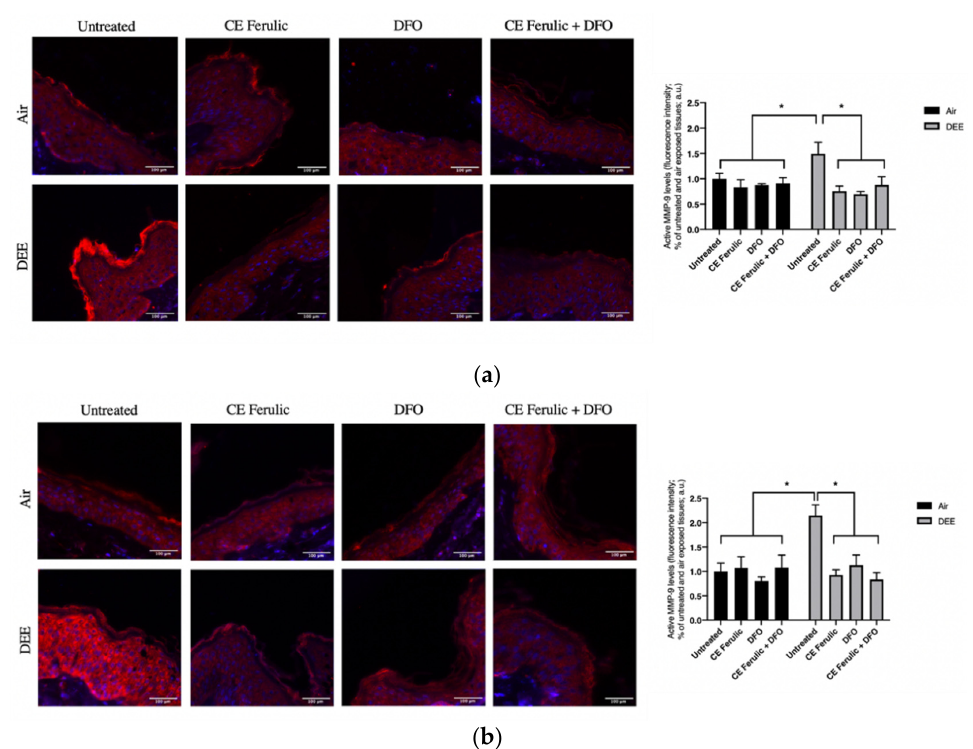
Figure 3. Skin exposure to DEE induces the levels of MMP-9 enzyme, while topical application of CE Ferulic and DFO counteracts this effect. Levels of MMP-9 in ex vivo human skin explants untreated or pretreated with the cosmeceutical formulation mixture and DFO, alone or in combination, and exposed to air or DEE at Day 1 ( a ) and Day 4 ( b ). Red fluorescence staining represents MMP-9 immunoreactivity, while cell nuclei are stained in blue with DAPI. Original magnification 40×. On the right, semi-quantification of the immunofluorescence intensities performed by ImageJ are shown in the histograms. Data are expressed as arbitrary units (averages of three independent experiments), * p < 0.05, by ANOVA. Scale bar = 100 μ m.